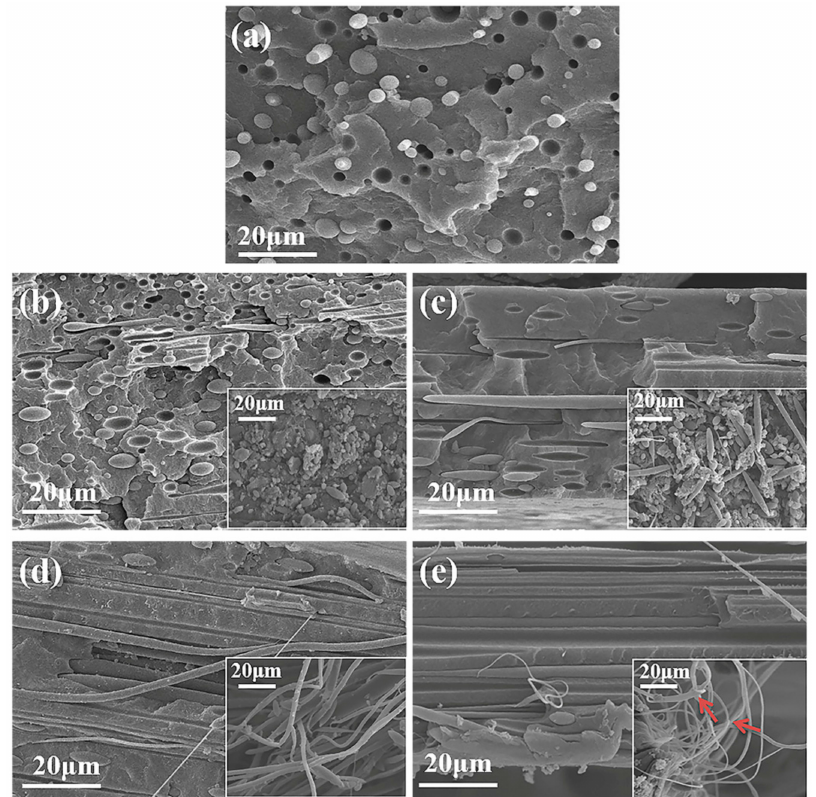
Figure 1. Scanning electron microscopy (SEM) images of cryo-fractured surfaces of the polypropylene (PP) / polyamide 6 (PA6) blends: ( a – e ) the samples with stretch ratios of 1, 2, 7, 11 and 16, respectively. The inset images are SEM images of cryo-fractured surfaces of the PP / PA6 blends after etching PP matrix. The diameter distribution of the PA6 dispersed phases in the PP / PA6 blends with di ff erent stretch ratios is shown in Figure 2a–e. The average diameter ( D ave ), fitted by log-normal distribution